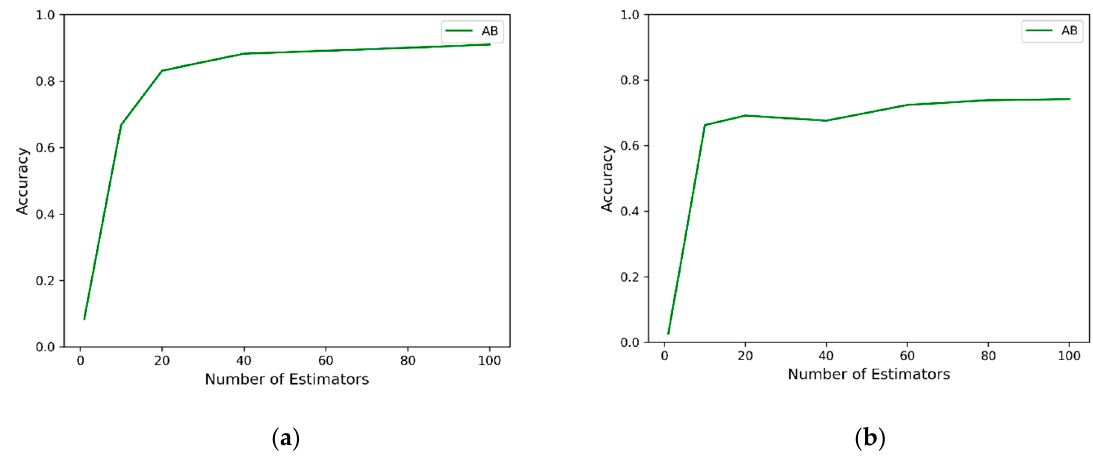
Figure 11. Accuracy in the prediction of ( a ) plastic viscosity and ( b ) apparent viscosity using AdaBoosting algorithm.